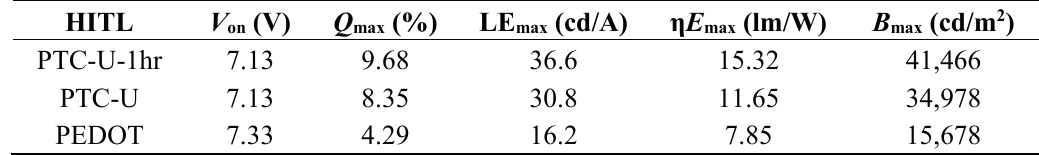
Table 2. EL Data for Devices Having the Structure ITO/HITL/Ir(ppy) 3 :PVK/BCP/Alq 3 /LiF/Al.